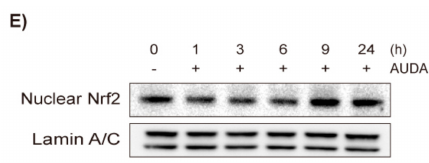
Figure 1. Soluble epoxide hydrolase (sEH) inhibitors inhibit platelet-derived growth factor (PDGF)-induced vascular smooth muscle cell (VSMC) proliferation by heme oxygenase-1 (HO-1) induction and Pin1 suppression. ( A , B ) Effects of 12-(((tricyclo(3.3.1.13,7)dec-1-ylamino)carbonyl)amino)- dodecanoic acid (AUDA). ( A ) and 1-cyclohexyl-3-dodecyl urea (CDU). ( B ) on VSMC proliferation. Rat VSMCs were treated with vehicle control, AUDA (0.3 to 10 µ g/mL), or CDU (0.3 to 10 µ M) 30 min prior to PDGF (30 ng/mL) exposure. VSMC proliferation was monitored 48 h after PDGF treatment by thiazolyl blue tetrazolium bromide (MTT) assay; ( C ) Effect of AUDA on Pin1 expression in VSMC. Vehicle control or AUDA (1 to 30 µ g/mL) was treated 30 min prior to PDGF (30 ng/mL) exposure. Total cell lysates were obtained 24 h after PDGF treatment and subjected to Pin1 immunoblotting ( n = 3); ( D ) Effects of AUDA on HO-1 and Kelch Like ECH Associated Protein 1 (Keap1) expression. VSMCs were incubated with vehicle control or AUDA (0.3 to 30 µ g/mL) for 24 h and HO-1 and Keap1 expression was determined by immunoblottings ( n = 3); ( E ) Effects of AUDA on nuclear level of nuclear factor erythroid 2-related factor-2 (Nrf2). VSMCs were incubated with vehicle control or 30 µ g/mL AUDA for indicated time points and nuclear extracts were subjected to Nrf2 immunoblotting ( n = 4). Statistical significance is indicated as * p < 0.05, ** p < 0.01, *** p < 0.001 vs. vehicle-treated control; # p < 0.05, ### p < 0.001 vs. PDGF-treated